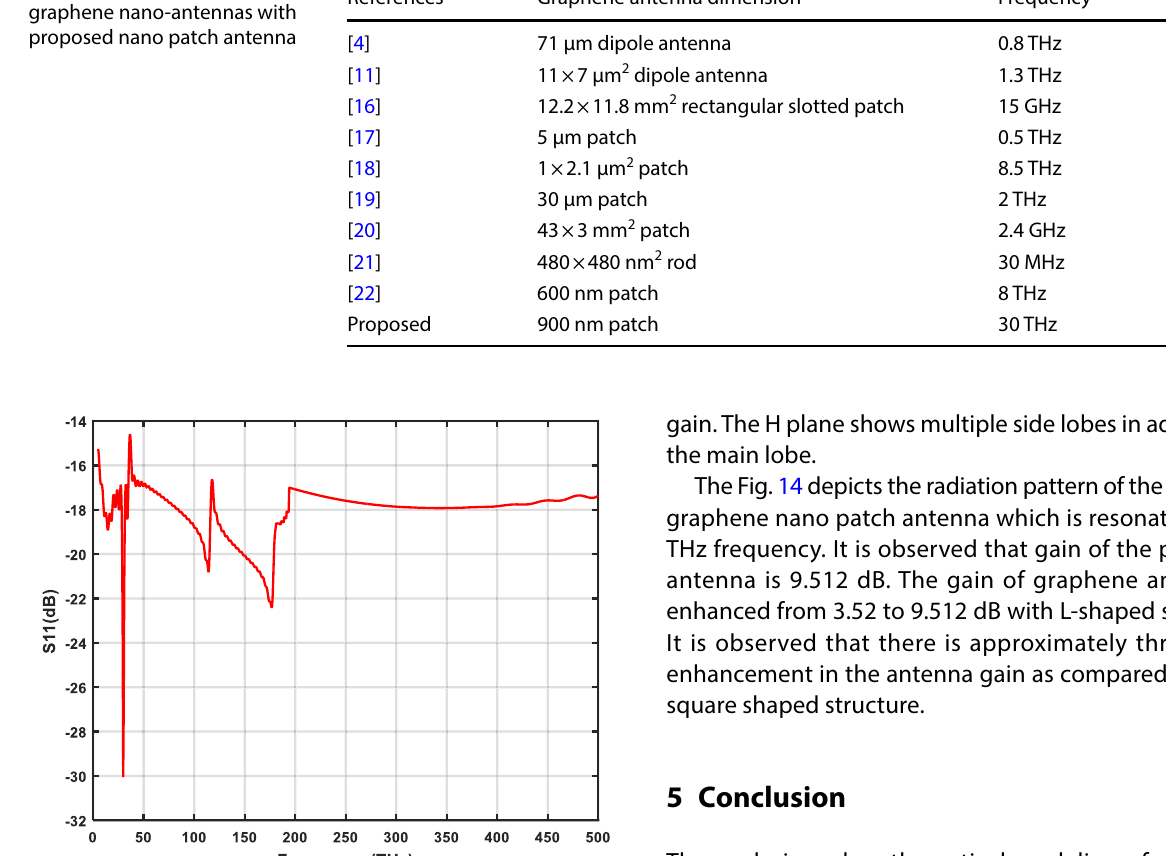
Table 1 Comparison of graphene nano-antennas with proposed nano patch antenna